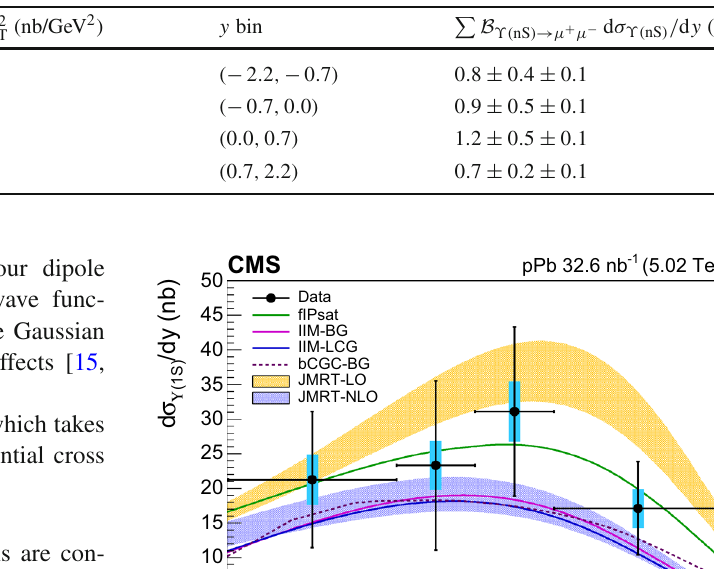
and y bins.Thefirstandseconduncertaintiescorrespond T